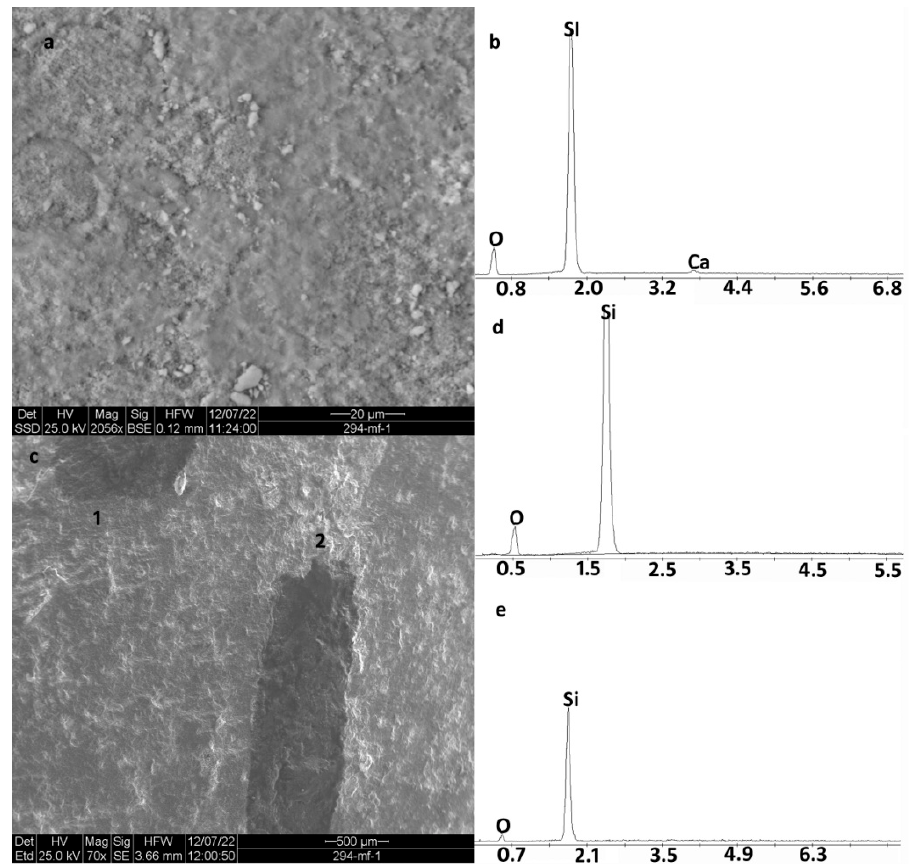
Figure 14. ( a ) The SEM photograph of the chert surface; ( b ) the typical chemical composition of the chert rock; ( c ) the study of the difference in chemical composition between black and white bands (both denoted by dark color), digits 1 and 2 indicate the location of the measurement points; ( d ) the typical chemical composition of the chert rock within the black band; ( e ) the typical chemical composition of the chert rock within the white band.